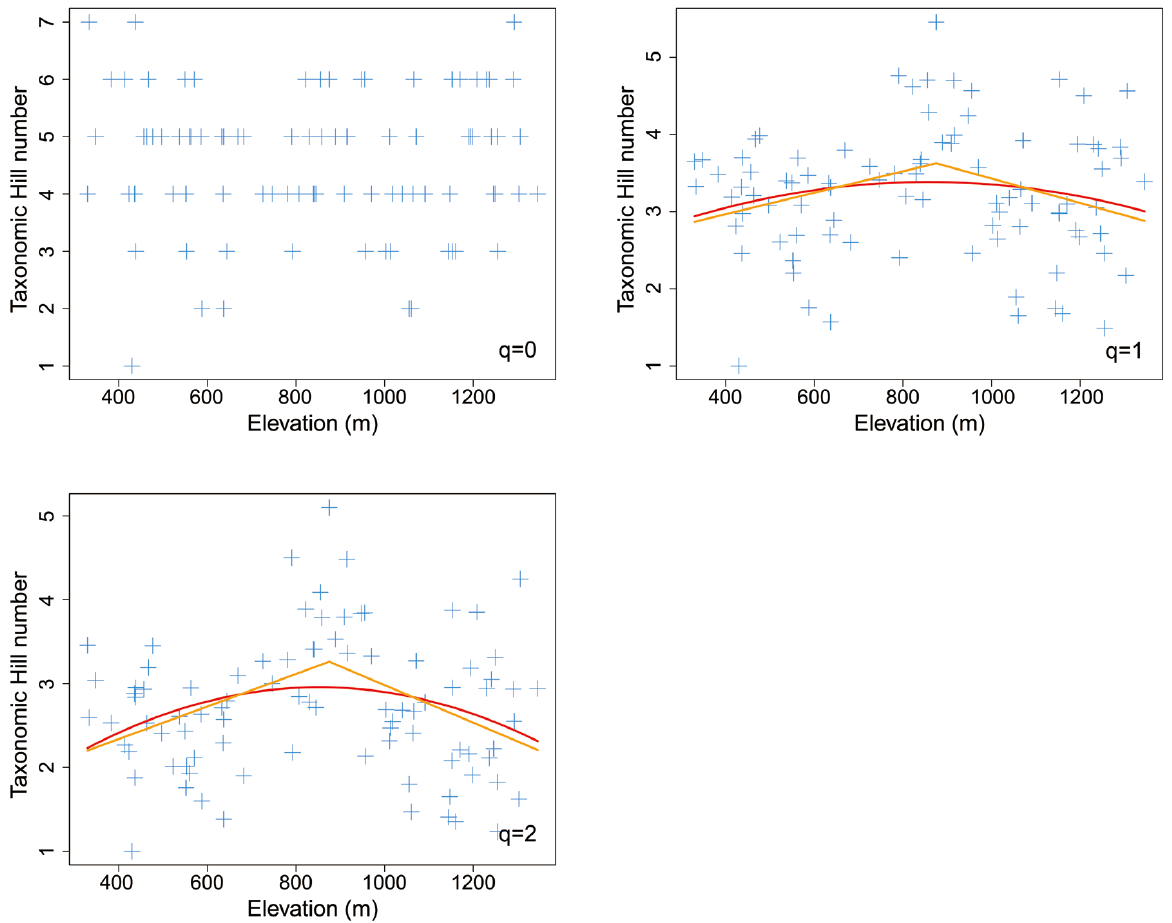
Figure 4. The elevational pattern of taxonomic Hill numbers for leaf mines on Quercus variabilis Blume. The orange line was fitted with the piecewise linear model, while the red line was fitted with the nonlinear quadratic model.